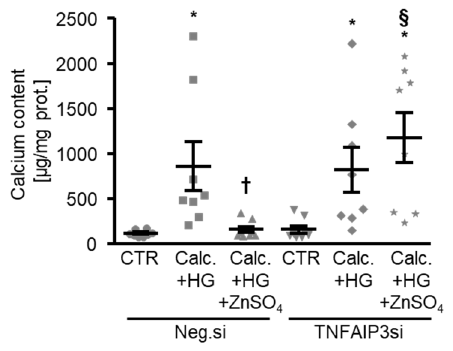
Figure 6. The silencing of TNFAIP3 interferes with the protective effects of zinc sulfate on the calcifi- cation of HAoSMCs under high-glucose conditions. Calcium content ( n = 8, µg/mg protein) in HA- oSMCs transfected with negative control (Neg.si) or TNFAIP3 (TNFAIP3si) siRNA and treated for 11 days with control (CTR) or calcification medium (Calc.) and high glucose levels (HG) in the ab- sence and presence of ZnSO 4 . * ( p < 0.05) significant difference versus the Neg.si-transfected CTR- treated group; † ( p < 0.05) significant difference between the Neg.si-transfected Calc.+HG- and